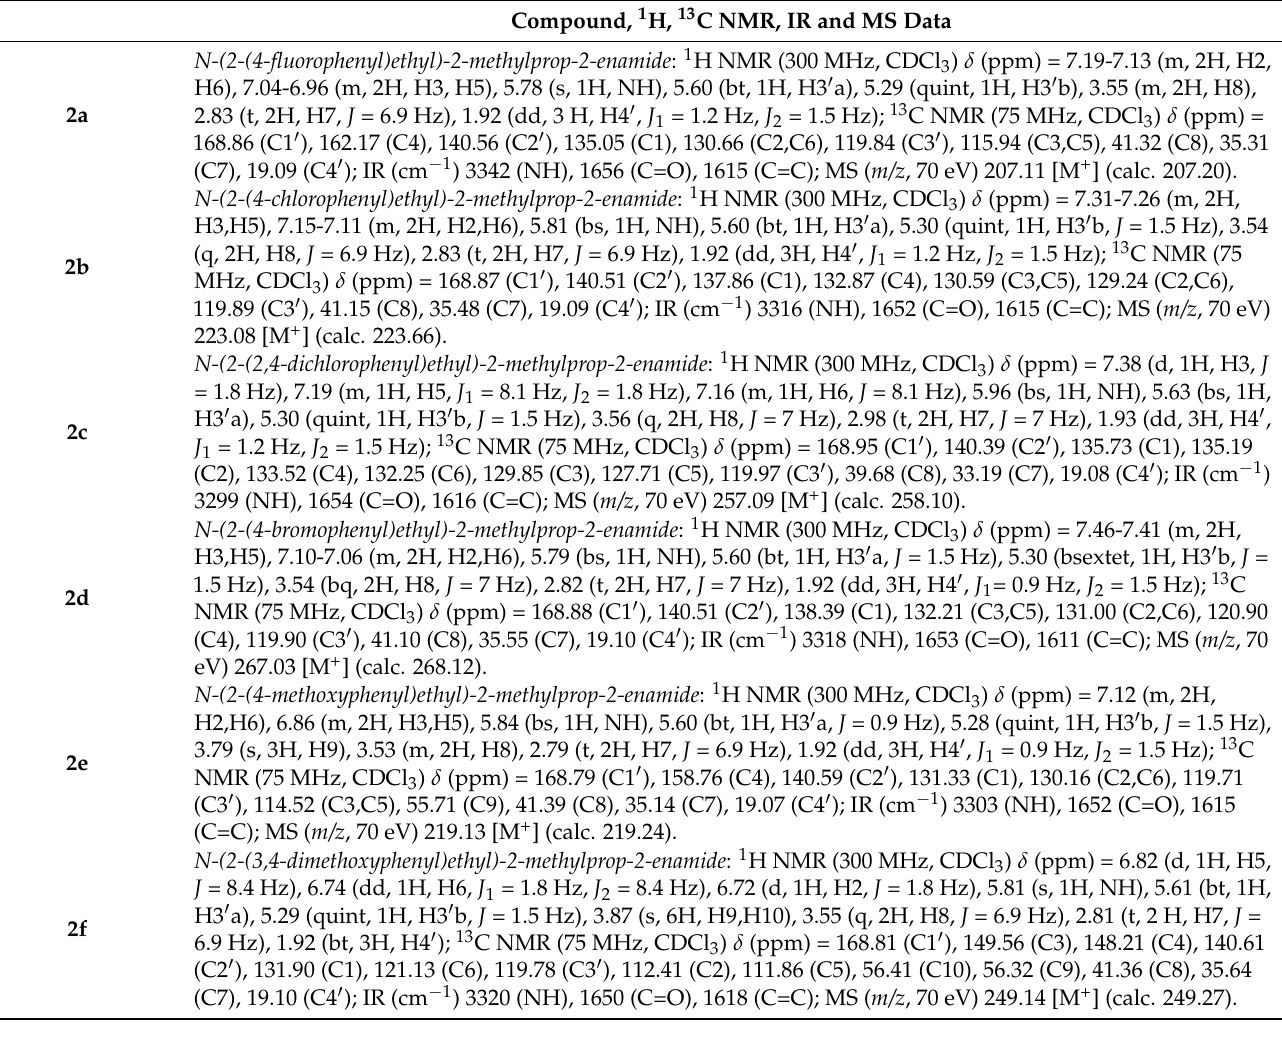
Table 2. Spectral data of synthesized